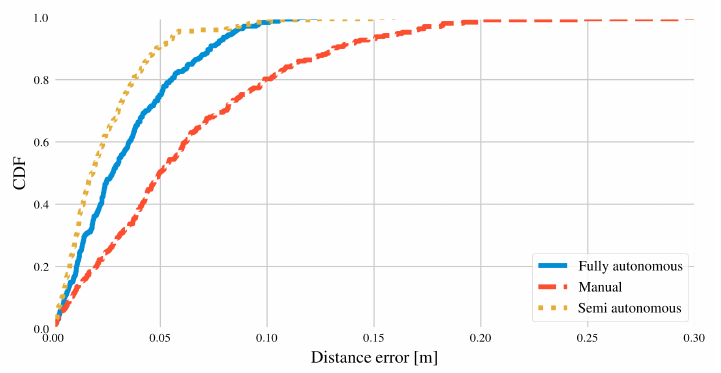
Figure 8. Cumulative error distribution for different calibration methods. The horizontal axis indicates the distance error as calculated by Equation